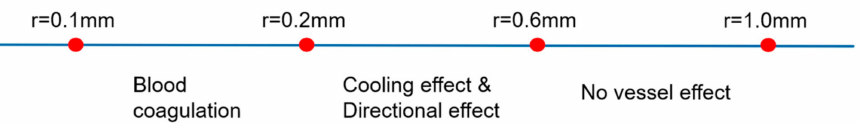
Figure 8. Classification diagram of the effect of micro-vessels on ablation effect (distance between fiber and vessel is 1 mm).